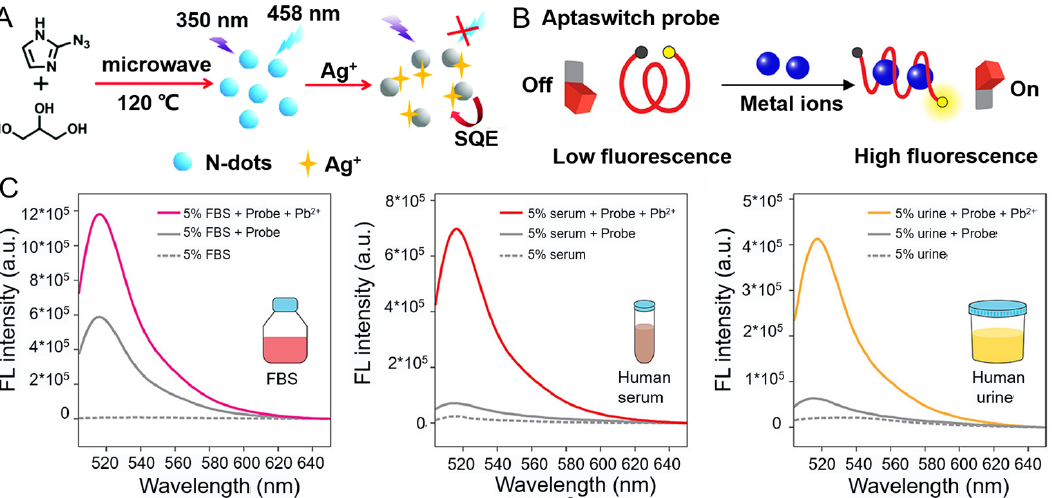
Figure 4. Two representative examples of non-essential metal ion detection in vitro: ( A ) Illustration of the synthesis process of nitrogen-rich CDs (N-dots) and the detection of Ag + . Reproduced from [85] with permission from the Royal Society of Chemistry, copyright 2019. ( B ) Concept of Pb 2+ detection using a fluorescent signal-on aptamer sequence (aptaswitch). ( C ) Detection of Pb 2+ in biological fluids by the aptaswitch probe. Reproduced from [87] with permission from the American Chemical Society, copyright 2022.